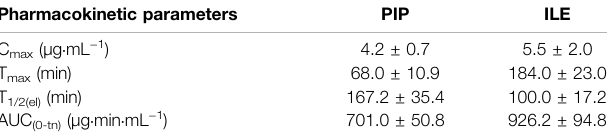
TABLE 6 | Pharmacokinetic parameters of PIP and ILE.